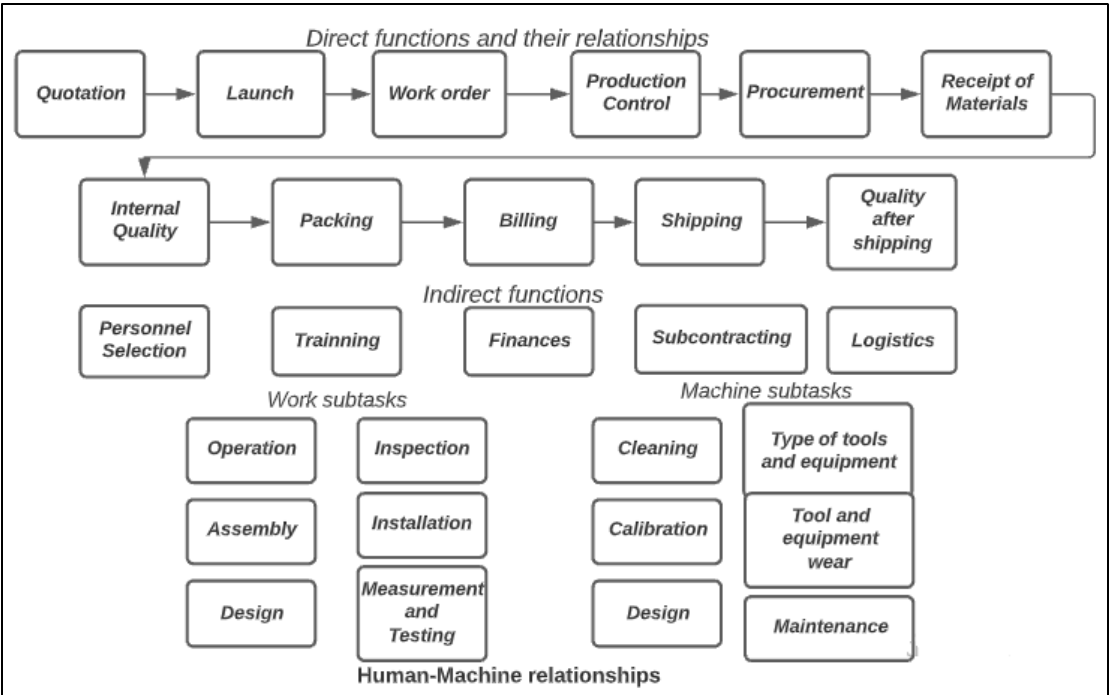
Figure 3. The production system of the human–machine system.